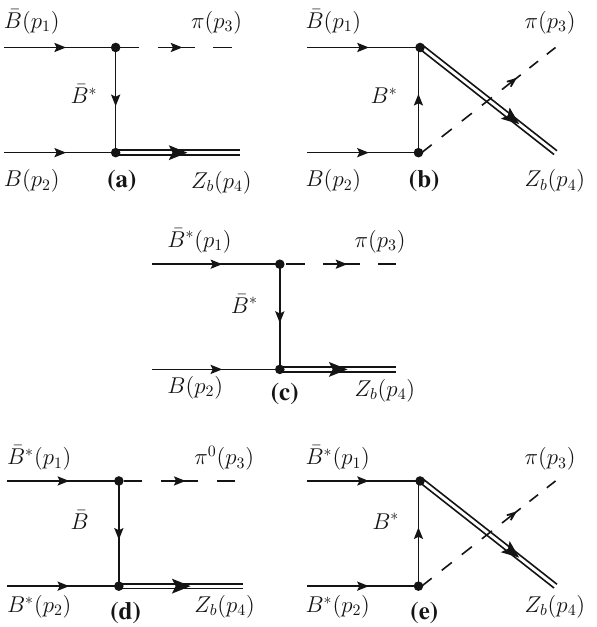
Fig. 1 Diagrams contributing to the process ¯ BB → π Z b [diagrams ( a ) and ( b )], ¯ B ∗ B → π Z b [diagram ( c )] and ¯ B ∗ B ∗ → π Z b [diagrams ( d ) and ( e )], without specification of the charges of the particles (from Ref. [14])